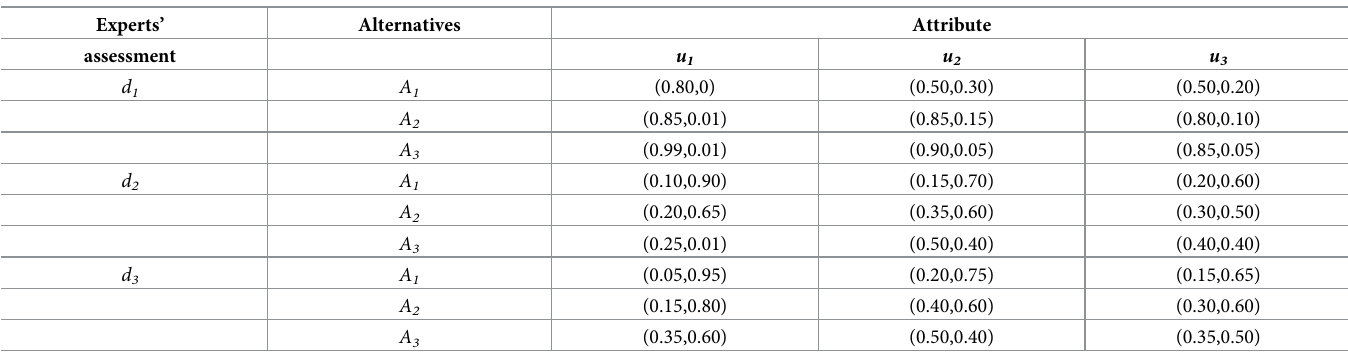
Table 8. Three scores matrices of attributes.